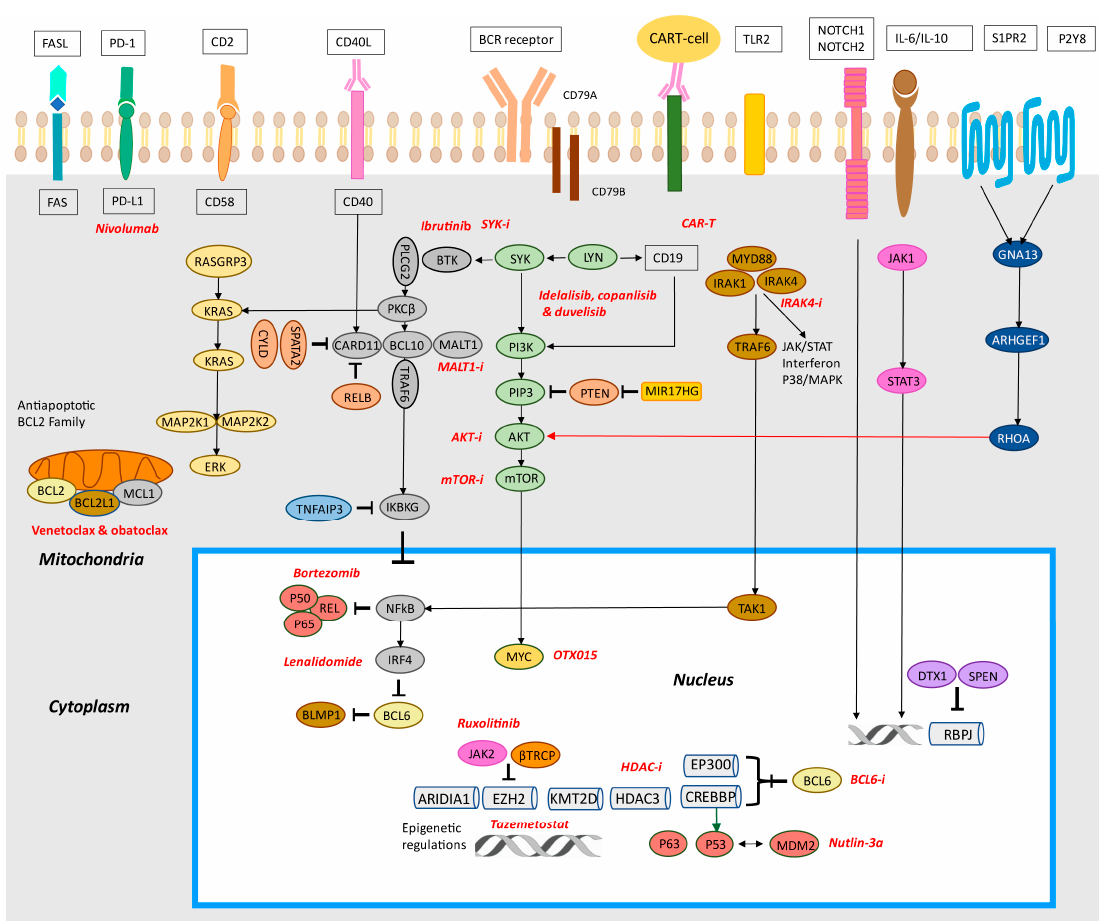
Figure 3. Main pathways involved in the proliferation and survival of DLBCL lymphoma and their potential